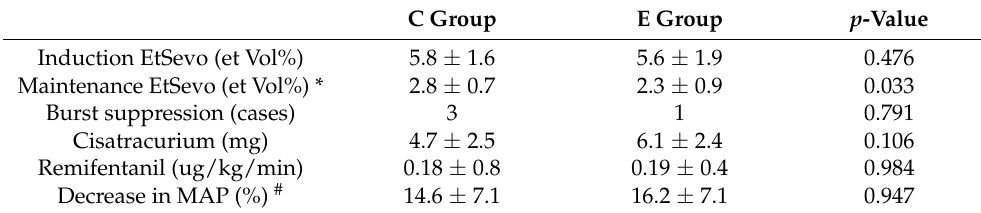
Table 3. Comparison results between two groups